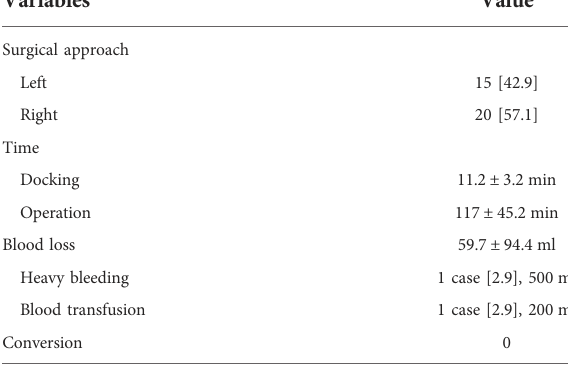
TABLE 1 Patient characteristics.